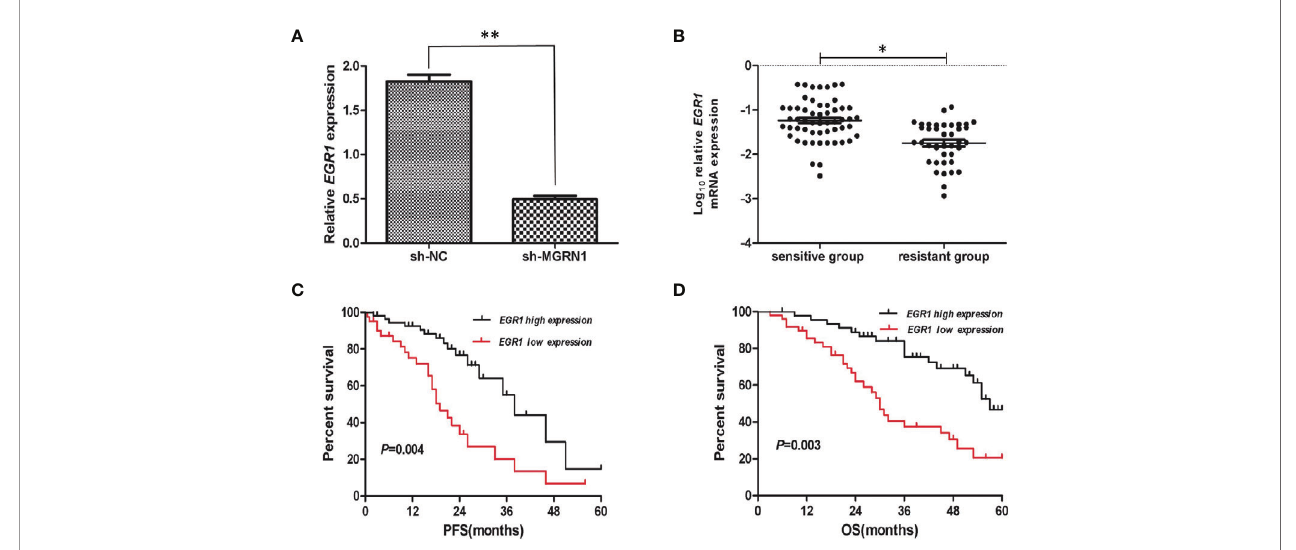
FIGURE 3 | The low mRNA expression of EGR1 was associated with platinum-resistant in HGSOC patients. (A) RT-qPCR showed the reduced expression of EGR1 in sh- MGRN1 cells compared to shNC cells. (B) The mRNA expression of EGR1 in platinum-resistant HGSOC patients and platinum-sensitive HGSOC patients. (C, D) Kaplan-Meier analysis of PFS and OS according to the EGR1 mRNA expression in HGSOC patients. * P < 0.05, ** P <